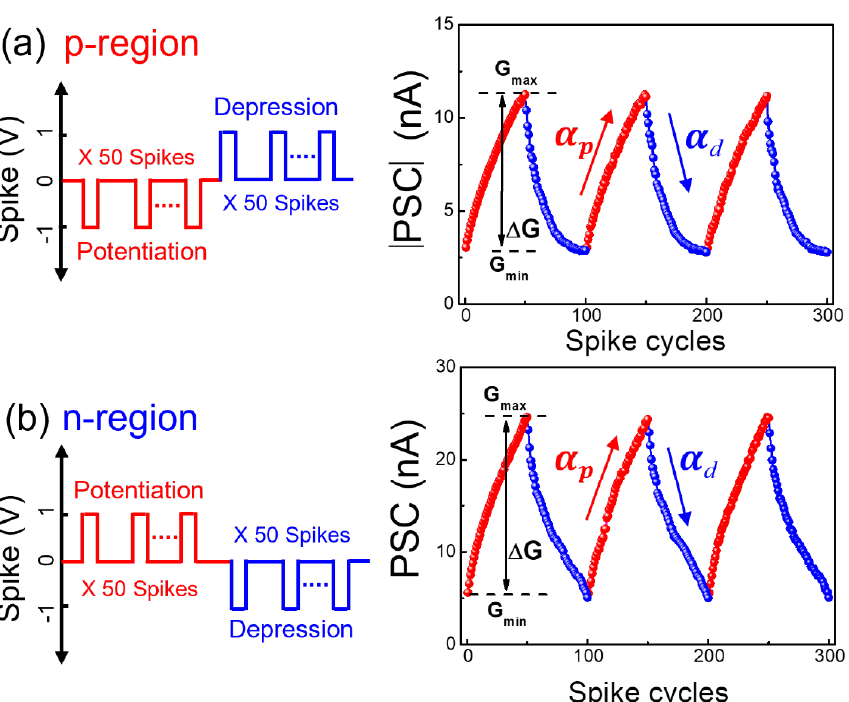
Figure 9. Synaptic weight update states characterized by the gradual potentiation/depression curves for the ( a ) p- and ( b ) n-regions.